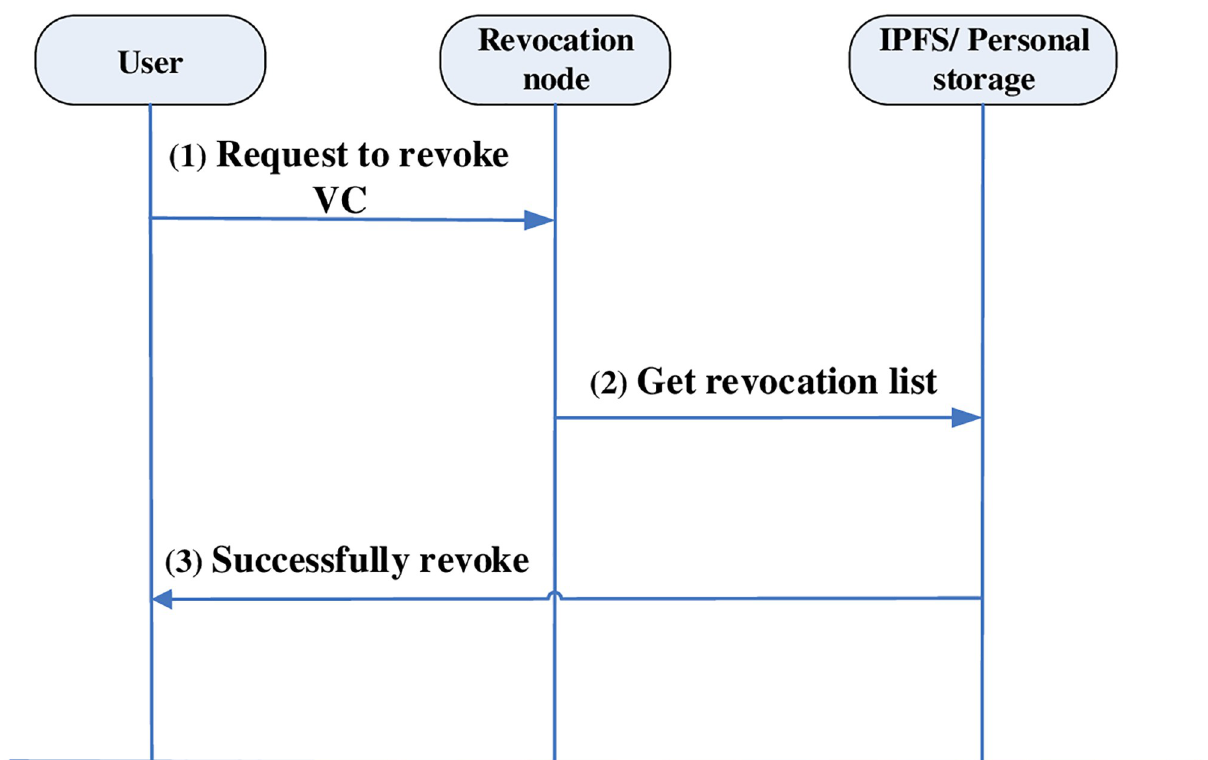
Fig 11. VC revocation process.